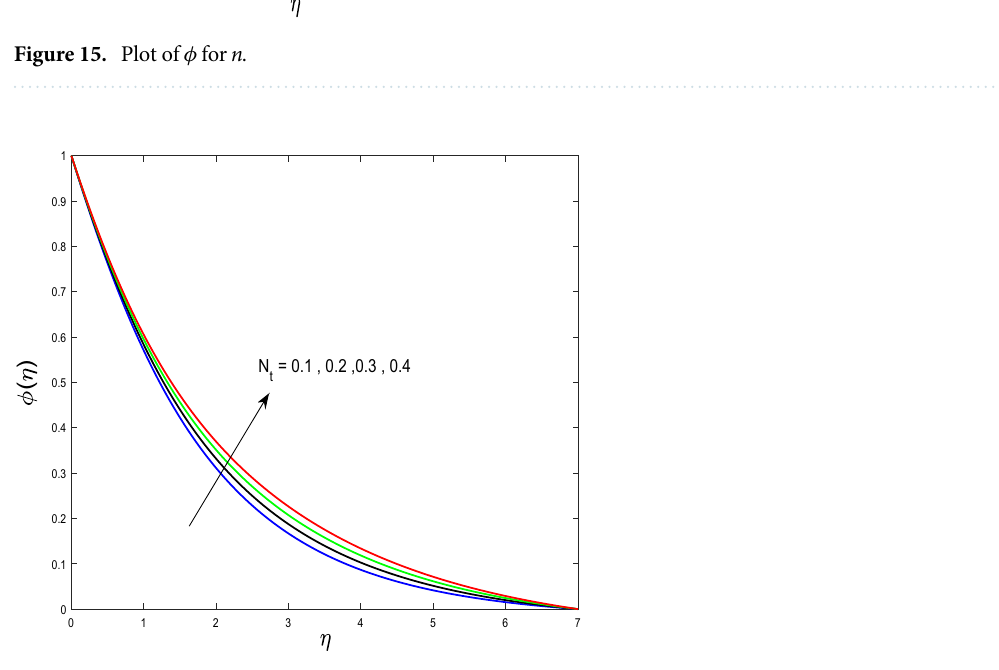
Figure 16. Plot of φ for Nt